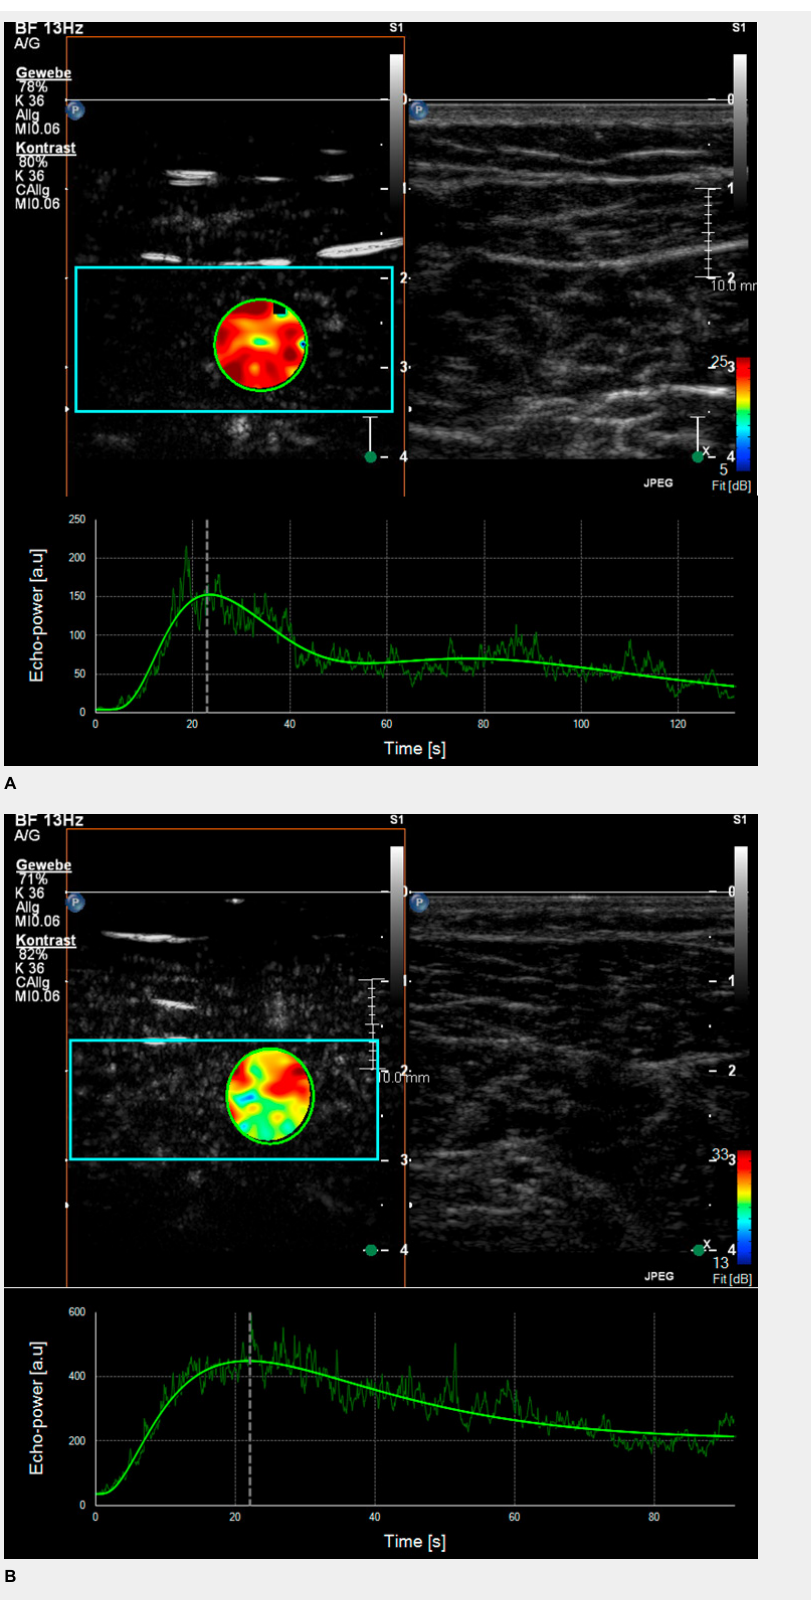
Figure 4 Skeletal muscle microperfusion on CEUS in a healthy volunteer (A) and a patient with peripheral artery disease (B). Corresponding time- intensity-curves of a region of interest (green circle) within the skeletal muscle (soleus muscle) after bolus injection of the ultrasound contrast agent with different shape in the healthy volunteer compared to the patient with peripheral artery